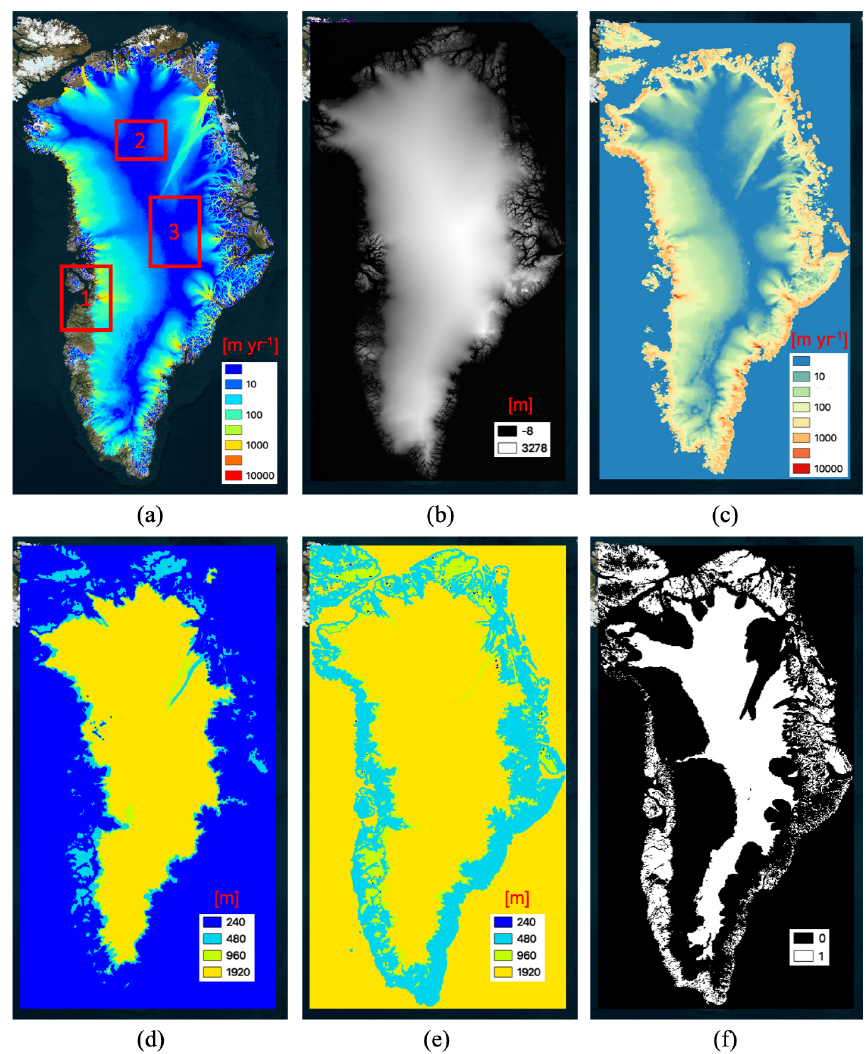
Figure 1. Input to the Sentinel-1 processing chain: (a) reference velocity magnitude with test sites shown as red rectangles, (b) elevation, (c) search limit in x , (d) minimum chip size, (e) maximum chip size, (f) stable surface mask that is defined as ice-free terrain or areas having a reference velocity < 15myr − 1